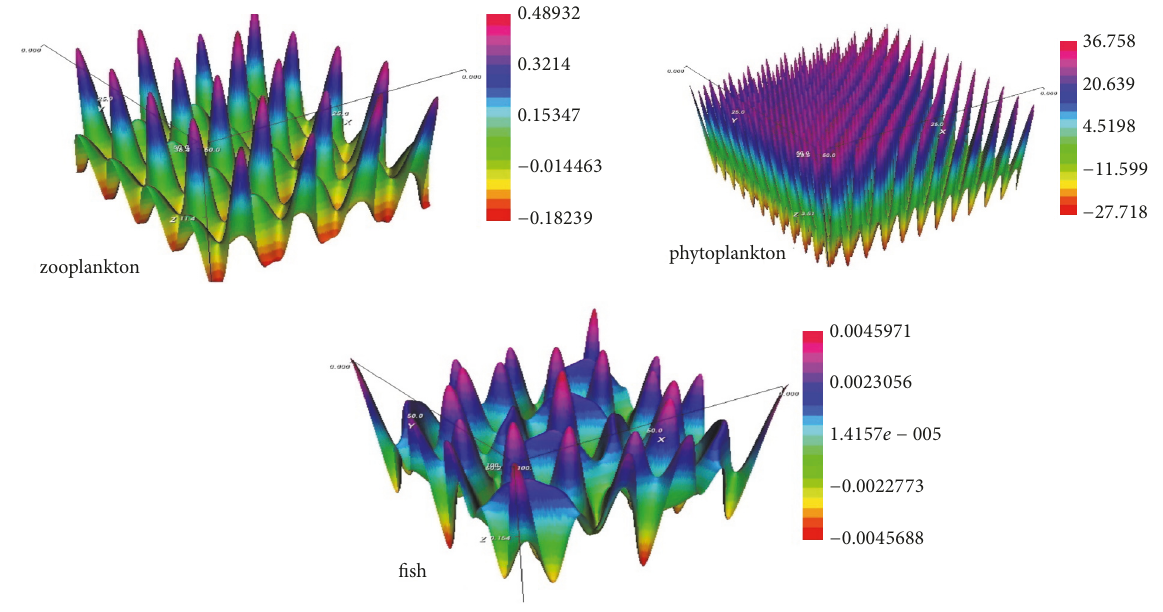
Figure 11: Dynamics behavior for 𝜃 𝑝 = 0.935 . Table 1: Numerical values for the parameters of